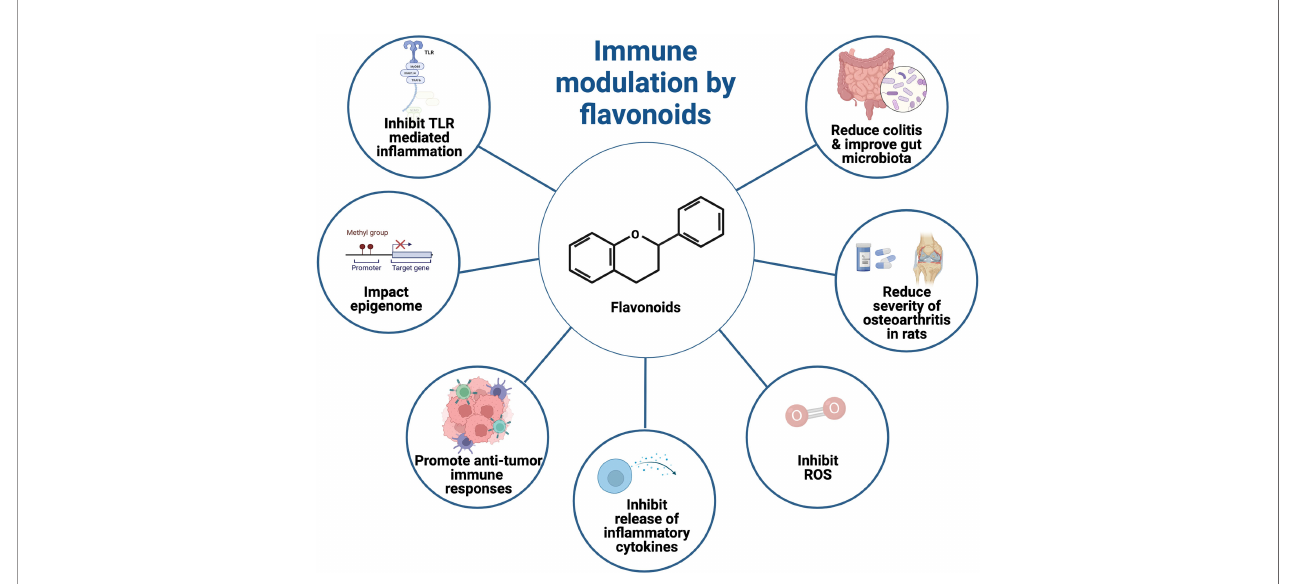
FIGURE 1 | Flavonoids that modulate immune responses may have bene fi cial therapeutic potential. Image created using